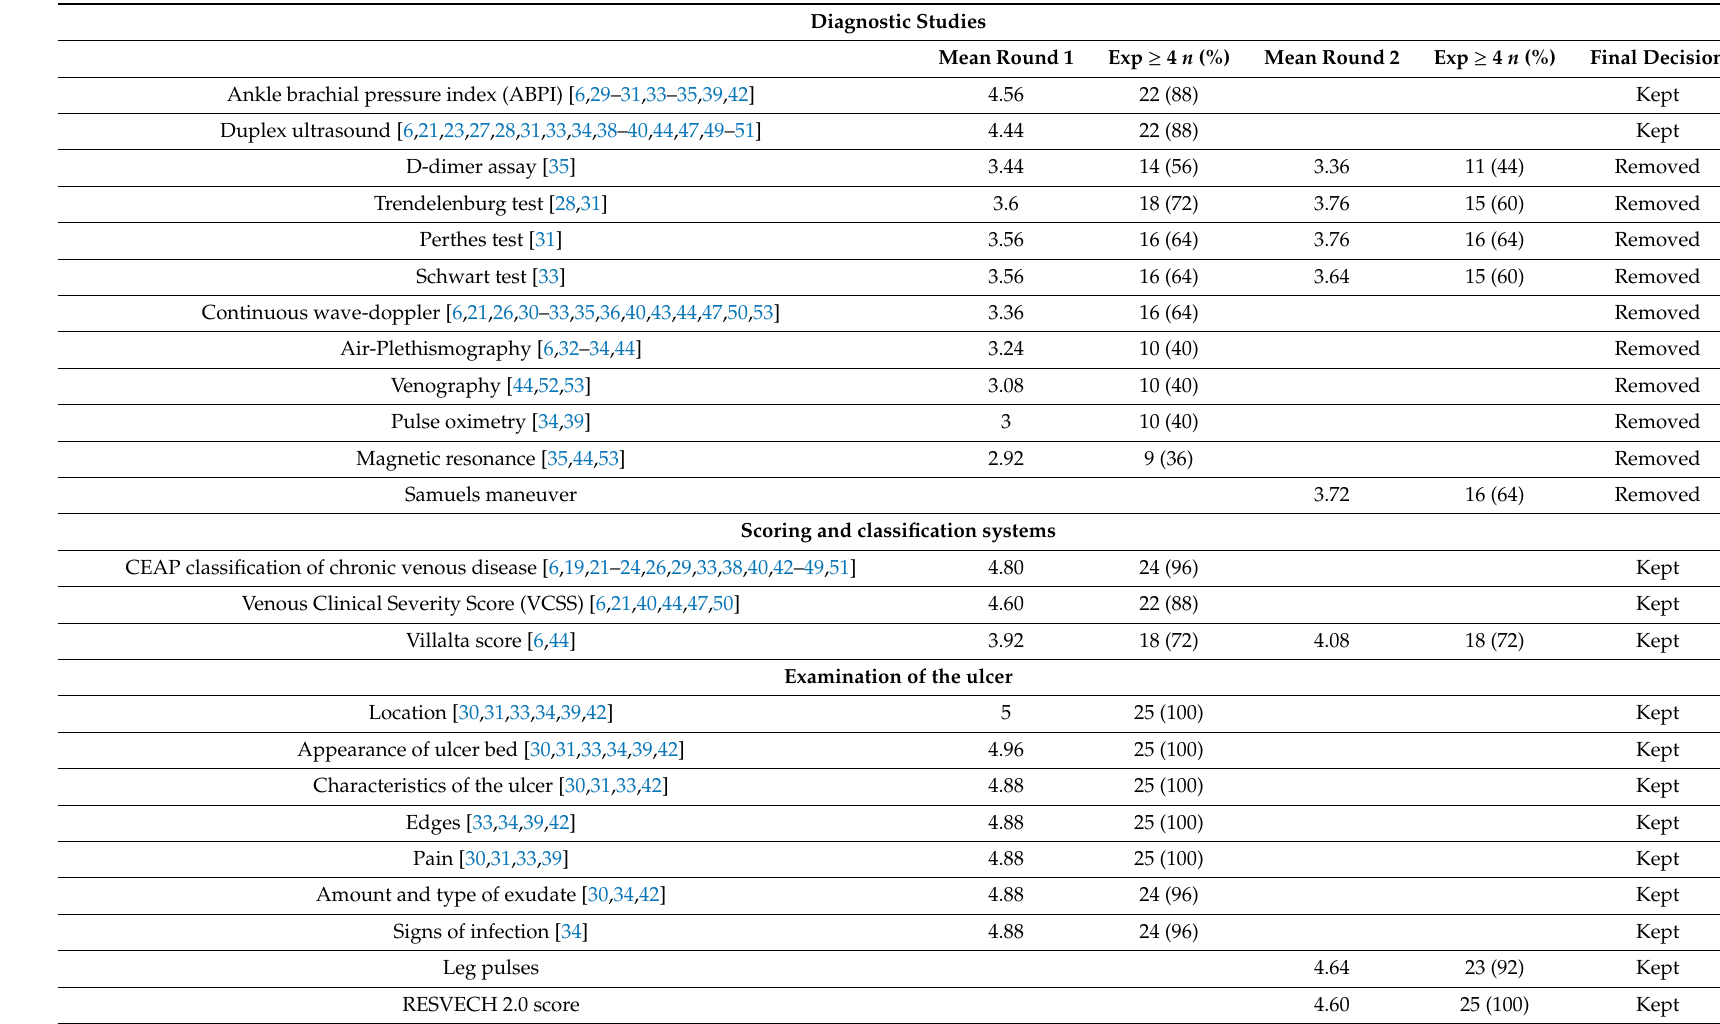
Table 2. Items related to diagnosis, scoring classifications systems, and examination of the